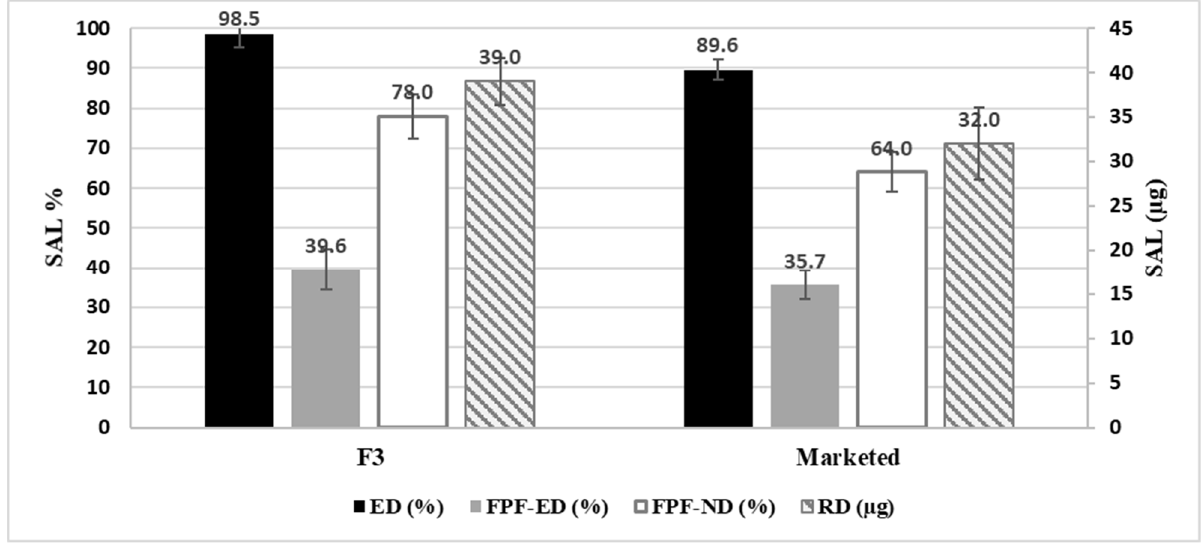
Figure 8. Aerodynamic behavior of SAL from Formula F3 containing nanocapsules, highlighting the main parameters for the formulation. ED: emitted dose; FPF-ED: fine particle fraction of emitted dose; FPF-ND: fine particle fraction of nominated dose; RD: respirable dose. Results are presented as mean ± SD, n = 3.